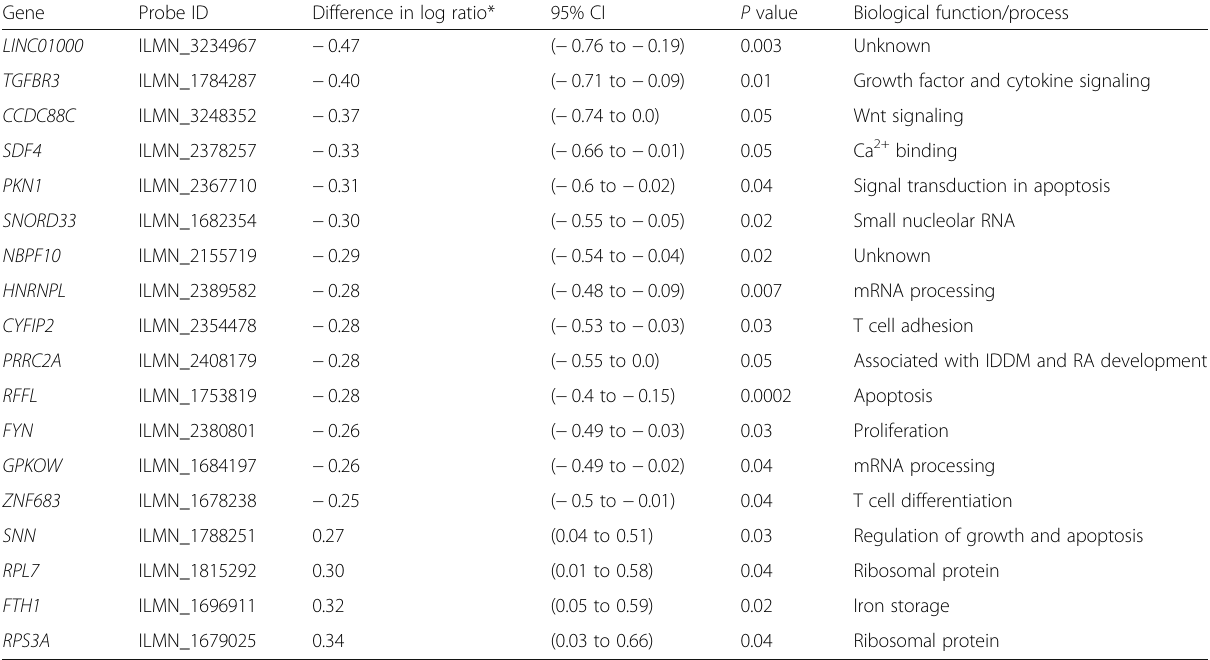
Table 3 Genes with the most altered expression (log 2 ratio > |0.25|) in responders compared to non-responders to omega-3